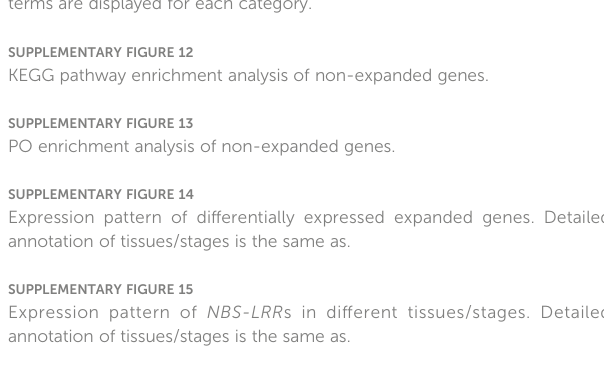
SUPPLEMENTARY FIGURE 16 Expression pattern of NBS-LRR s under different stresses. SUPPLEMENTARY FIGURE 17 Expression pattern of top 10 hub genes in tissue/stage (A) and stress (B) co-expression networks. Detailed annotation of tissues/stages is the same as. SUPPLEMENTARY FIGURE 18 DistributionoftheB3 genesonbarleychromosomes. Chromosomenumbers are shown at the top of each chromosome. The scale (Mb) notes on the left. The genes marked in red are expanded genes in barley. SUPPLEMENTARY FIGURE 19 Distribution of NBS-LRR s on barley chromosomes. Chromosome numbers are shown at the top of each chromosome. The scale (Mb) notes on the left. The genes marked in red are expanded genes in